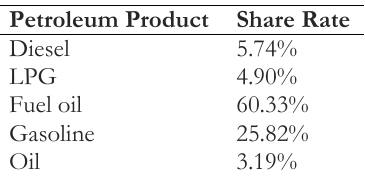
Table 4. The share of each petroleum product in